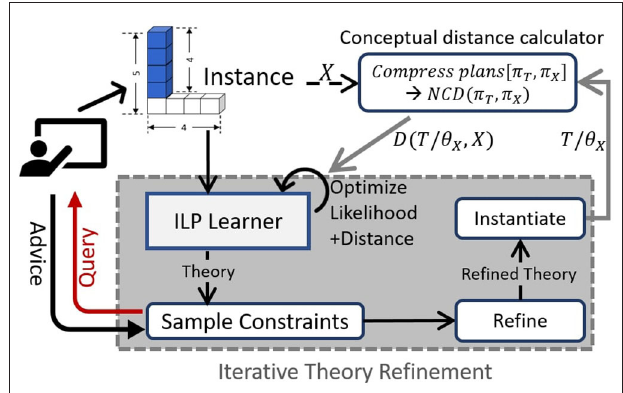
FIGURE 3 | Highlevel overview of our Guided One-shot Concept Induction (G OCI ) framework.